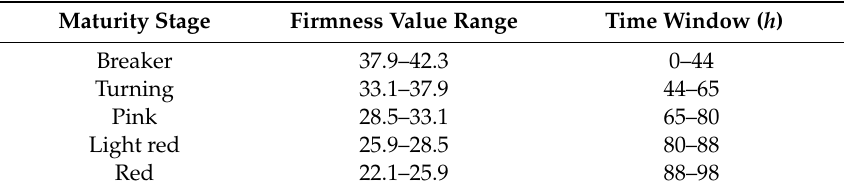
Table 3. Time windows for tomato di ff erent maturity base on